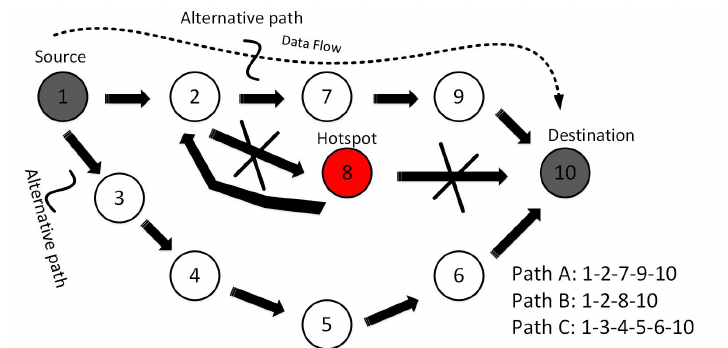
Figure 5. Alternative path for traffic: The red node represents hotspot node that has a high temperature. Whenever the packet will be transferred to hotspot node it will backtrack the packet to previous node and communication will continue from the alternative